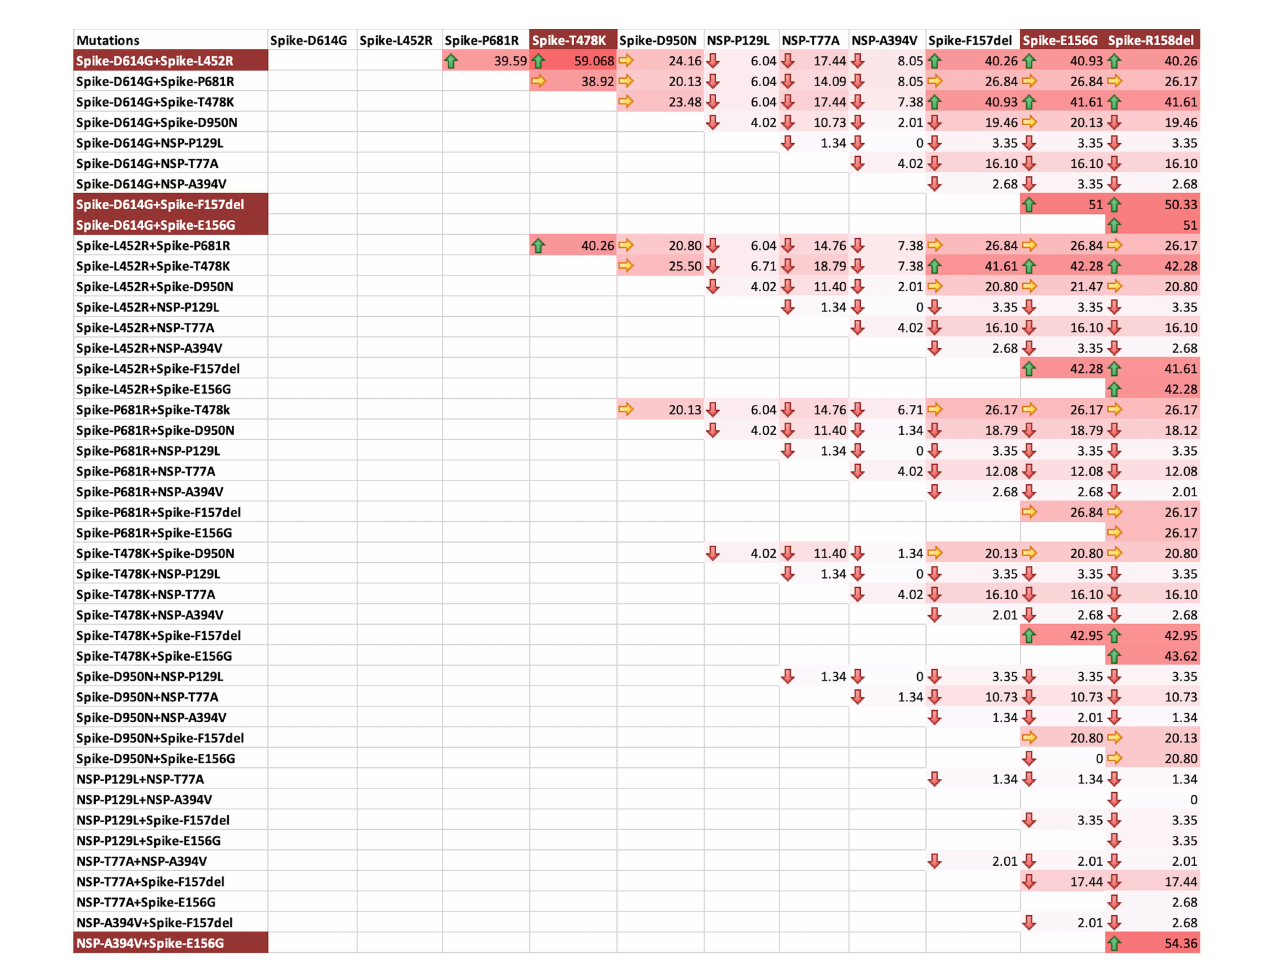
FIGURE 5 Three mutations combination matrix for identification of mutations facilitating vaccination breach during COVID-19 s waveThree mutations combination matrix for the identification of mutations facilitating vaccination breach during COVID-19 second wave. The background colour gradient from white to red indicates increasing frequency of combinations. Green arrows represent high frequency (>40), yellow arrows represent moderate frequency (20-40), and red arrows represent low frequency (<20). The background highlight in the mutation names indicates the most frequent